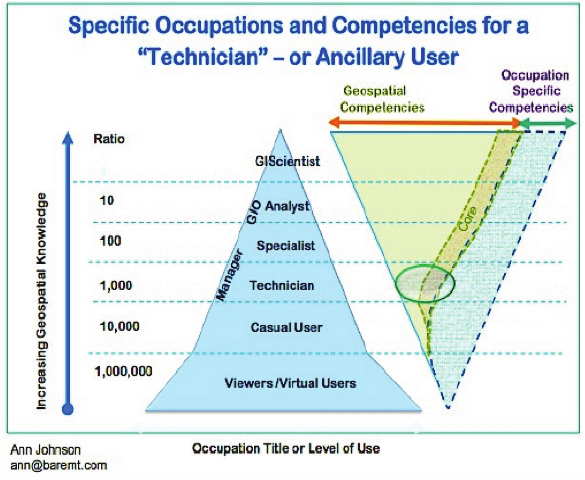
Figure 3. This schematic illustrates the role of the introductory level remote sensing technician within the workforce domain of geospatial technology, a role that has come into being only in the last few years with the advent of no-cost, easily-accessed land remote sensing data. An oval in the upside-down triangle at right indicates the level of competency targeted by the iGETT project. Figure 4. “Words cannot begin to describe the impact